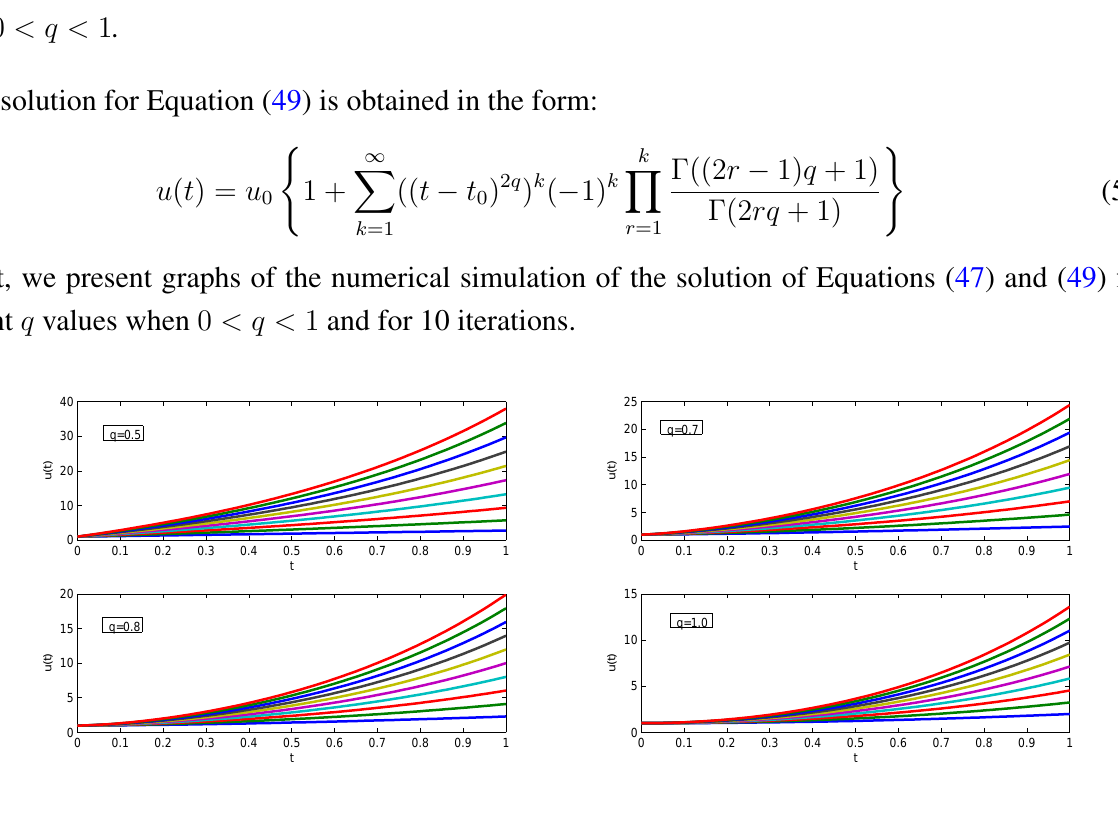
Figure 1. For the special case λ = ( t − t